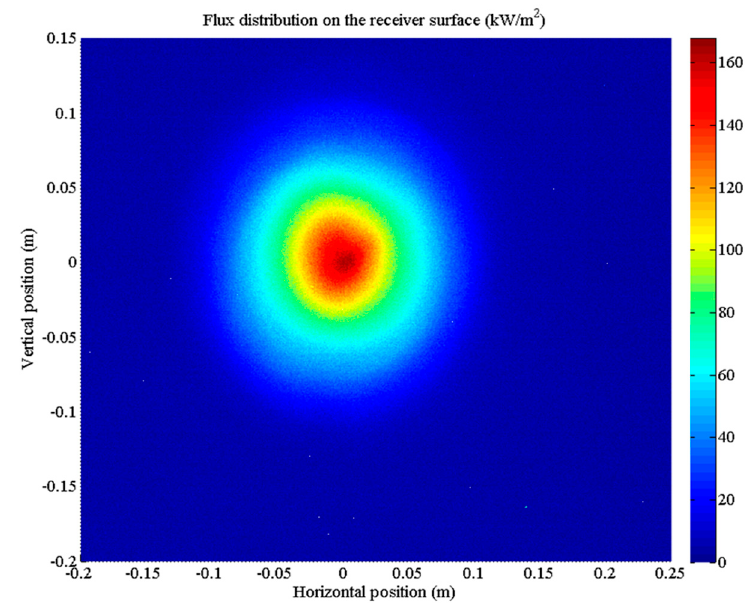
Figure 3. Energy flux distribution of 1–7 lamps with 50 A current when the mirrors were clean.